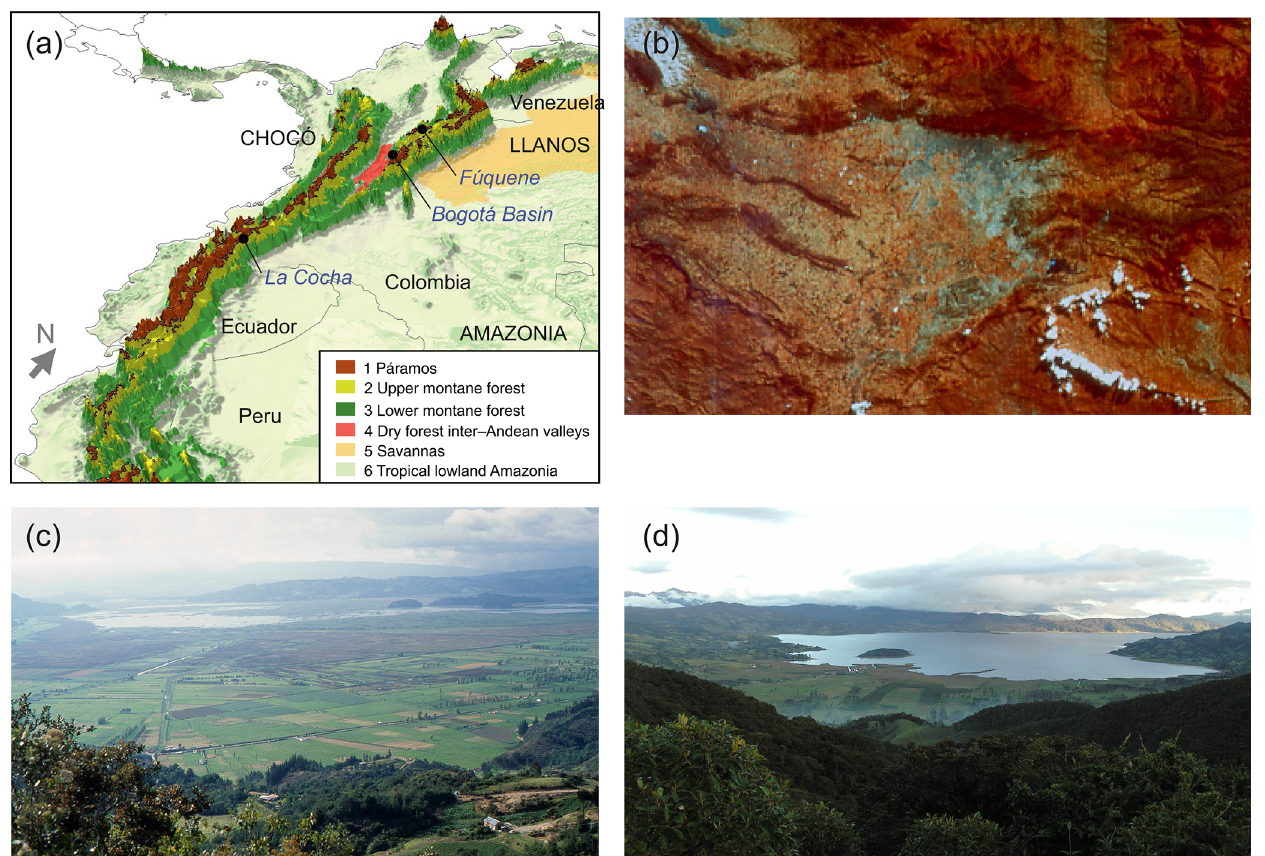
Figure 2. (a) Map of the Northern Andes showing the sedimentary basins discussed in the text. Photographs of the basins of Bogotá (b ), Lake Fúquene (c) , and Lake La Cocha (d) . Figure supplied by Suzette G. A. Flantua).